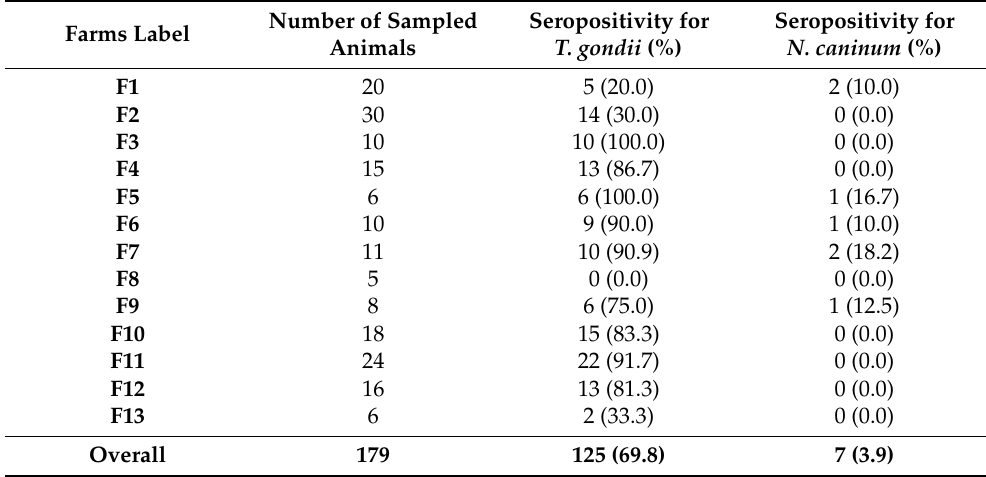
Table 3. Seroprevalence of T. gondii , N. caninum , and B. besnoiti antibodies in goats (n = 179) sampled from 13 farms in Selangor,